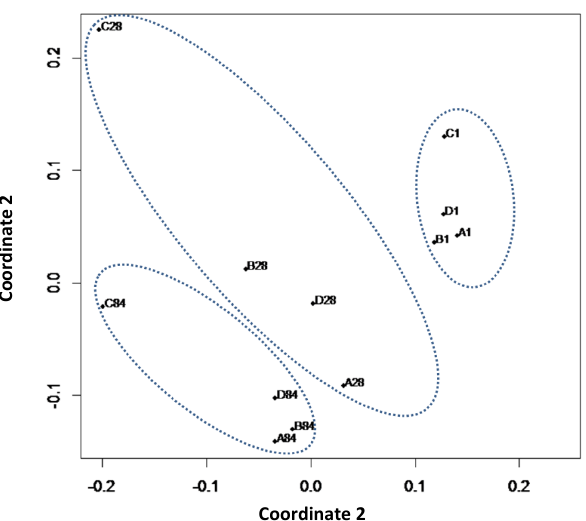
Figure 6. Metric multidimensional scaling analysis based on dis- tance matrix of OTU relative abundance in bioremediated soil sam- ples (A, B, C, D – names of the variants, as in Fig. 2; 1, 28, 84 – days of sampling).